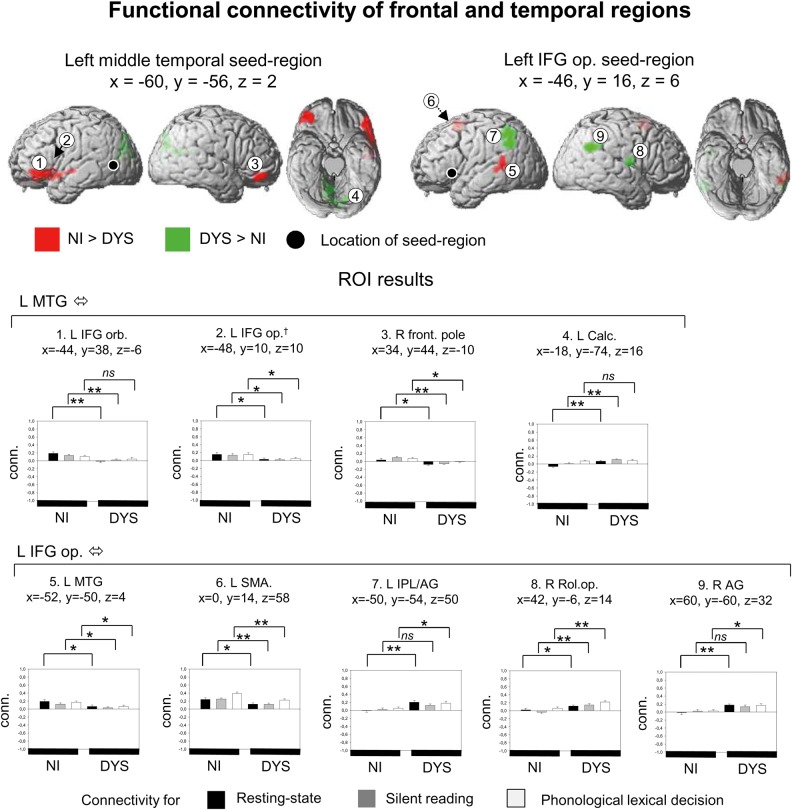
Functional connectivity for seed regions in the left posterior middle temporal gyrus and the left inferior frontal gyrus pars opercularis. † area found at an uncorrected threshold of p < 0.001 and 20 voxel extent on the whole-brain level. All other details same as in Figure 2.